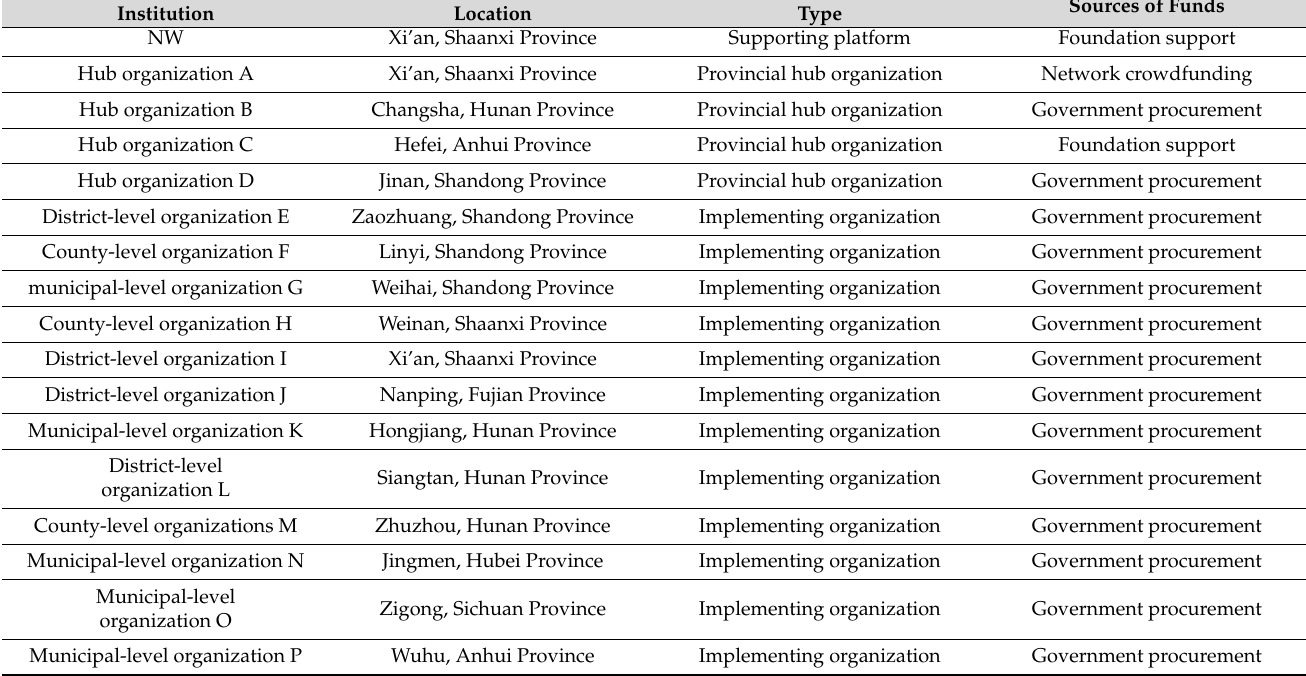
Table 1. Information about social organizations (provincial, municipal, district-level and county-level are indicated to show the administrative divisions that the organizations are registered